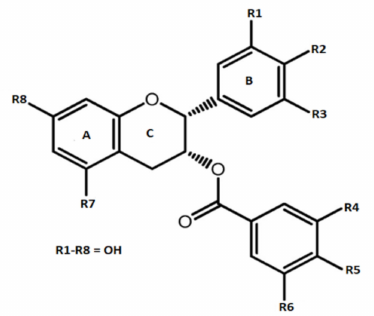
Figure 1. Chemical structure of epigallocatechin